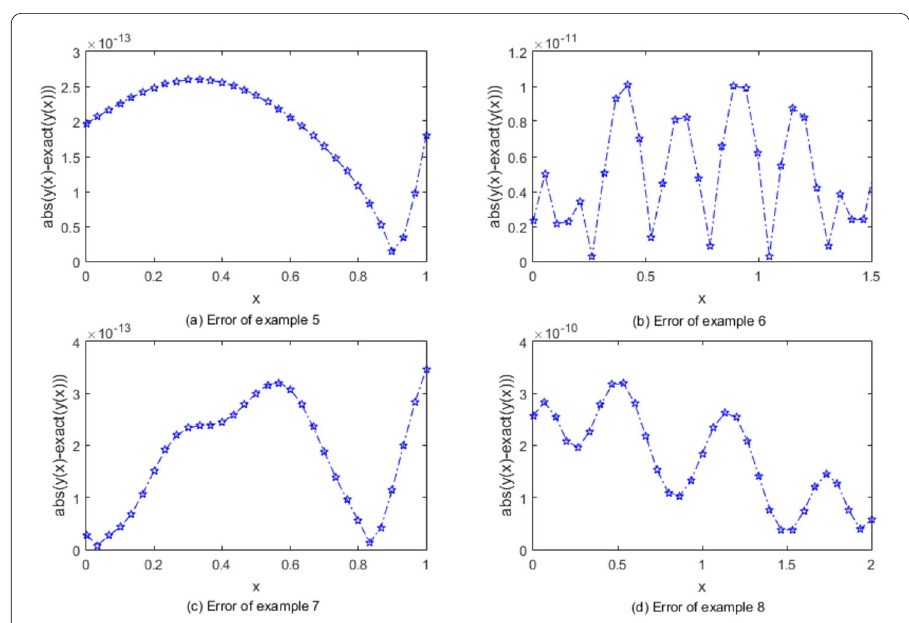
Figure 5 The absolute error for second-order